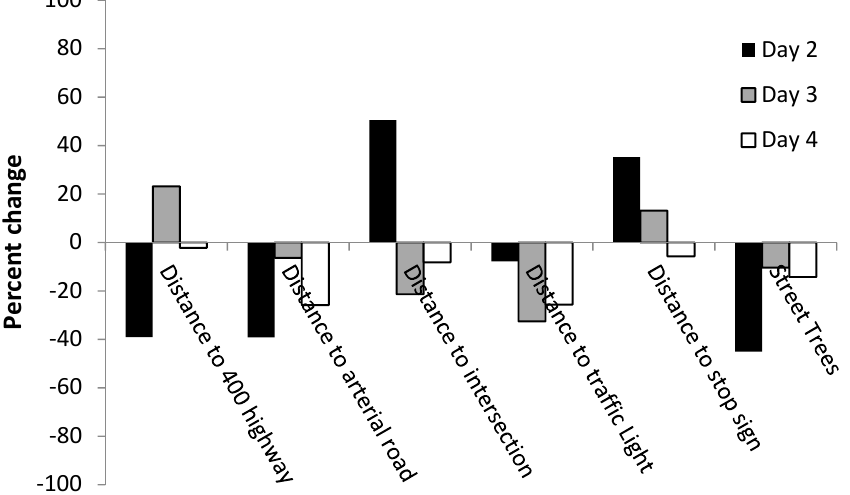
Figure 9. Percent change in traffic-related predictor variables between the 20% most heavily polluted segments of the cycled network and the remainder of the cycled path. * denotes an insignificant difference (two-tailed t -test, equal variances not assumed p > 0.05).